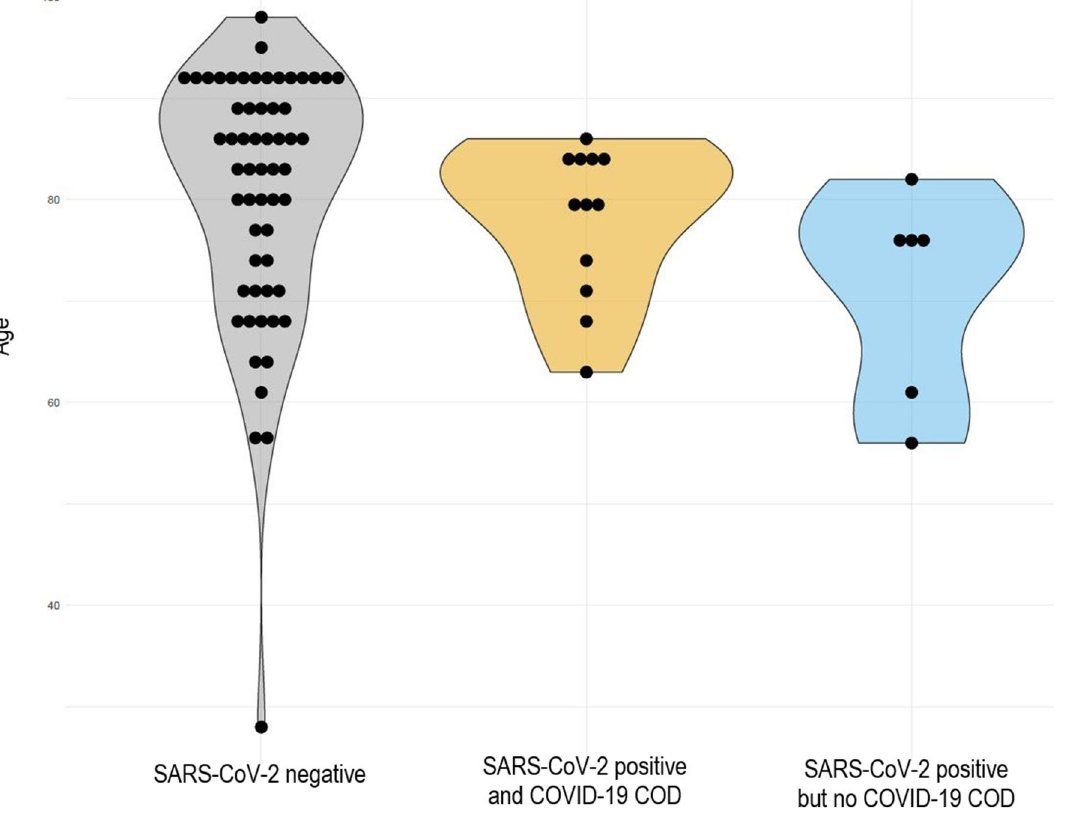
Figure 2. Age differences. All 77 deaths were differentiated into three groups: SARS-CoV-2 negative, SARS- CoV-2 positive, and COVID-19 underlying COD as well as SARS-CoV-2 positive but no COVID-19 underlying COD. There were no significant differences in the age distribution among COVID-19 infected or non-infected